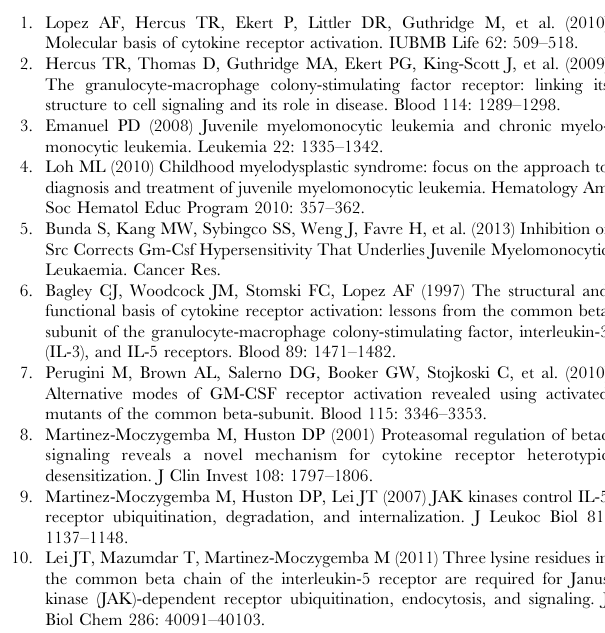
Figure S1 Knockdown of endogenous Cbl in TF-1 cells stabilizes Src but does not influence the rate of GMR b c turnover post-GM-CSF stimulation. Serum and cytokine starved TF-1-ShScr or TF-1-ShCbl cells were treated with GM- CSF for the indicated times, lysed and immunoblotted with the indicated antibodies. (TIF) Figure S2 Real-time qPCR analysis of shRNA-mediated SOCS-1 knockdown in TF-1 cells. The mRNA levels of SOCS-1 were measured by real-time qPCR in TF-1-shSOCS-1 and TF-1-shScr cells and normalized to b -Actin expression level. Expression level of SOCS-1 transcripts in TF-1-shScr cells was arbitrarily set to 1.0. Error bars represent standard deviations from three independent experiments performed in triplicates.